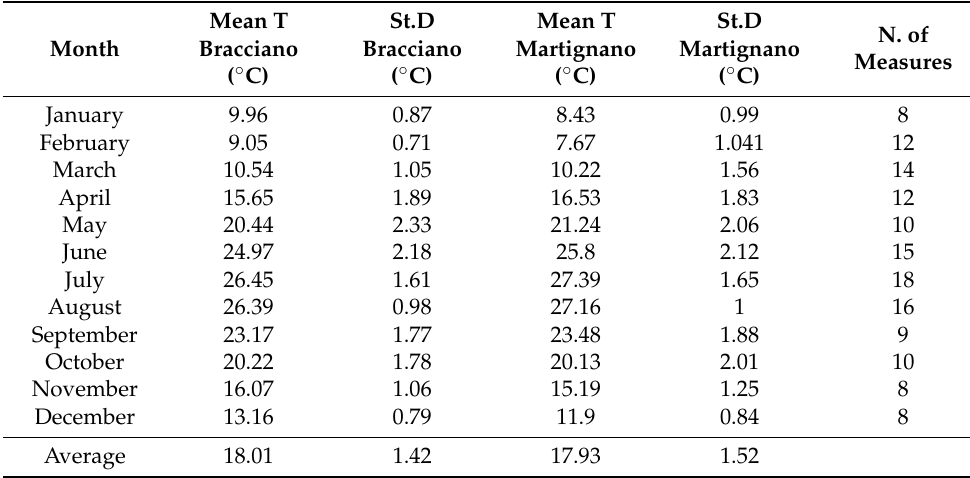
Table 8. Average year derived from Lansdat data acquired from 2000 to 2019 using our proposed approach for the atmospheric correction of Landsat